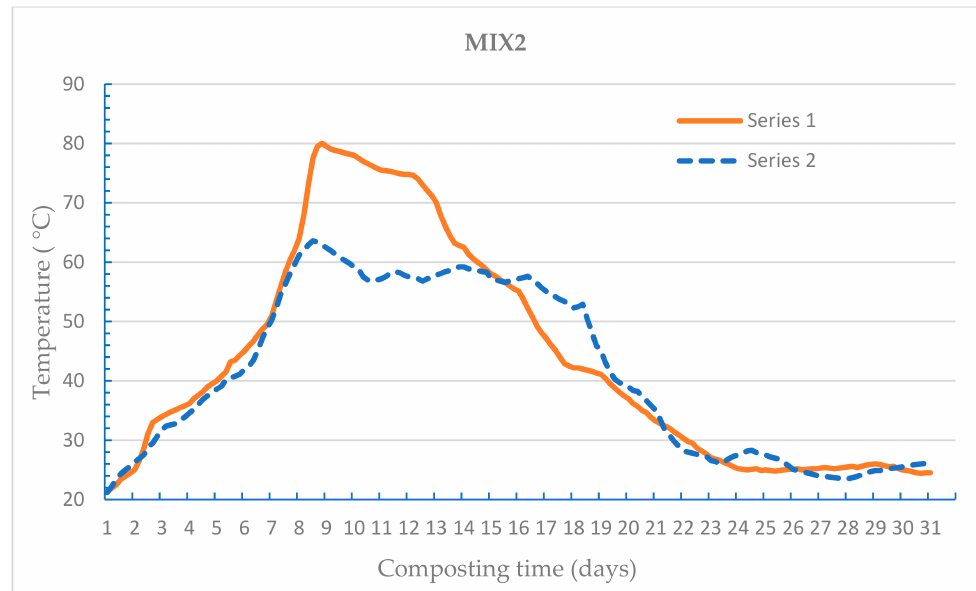
Figure 3. Changes in temperature during the composting of